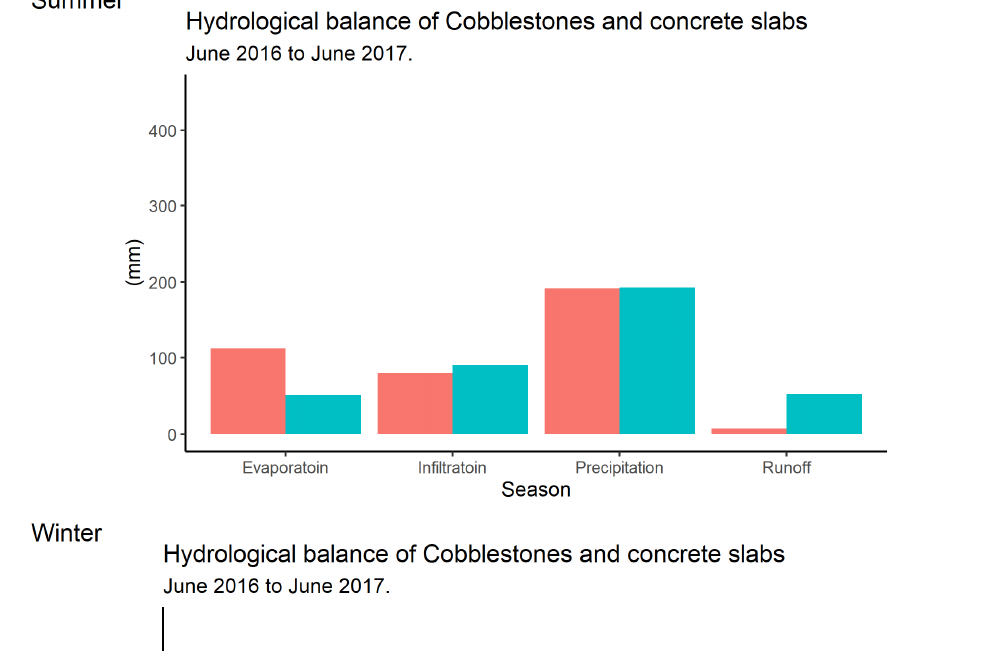
Figure 4. Distribution of soil moisture 5 cm beneath cobble stones and concrete slabs.